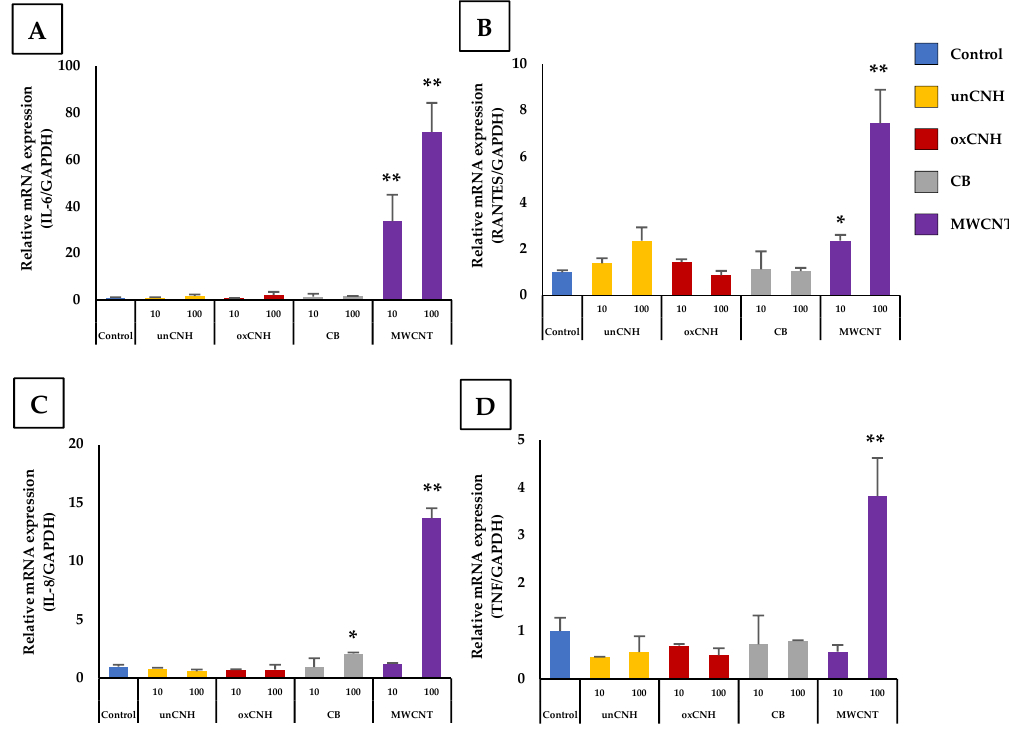
Figure 3. Gene expression of inflammation cytokines on HLEC exposed to varieties of carbon nanomaterials. ( A ) IL-6, ( B ) RANTES, ( C ) IL-8, ( D ) TNF. Data are expressed as mean ± S.E. ( n = 3). * p < 0.05; ** p < 0.01. HLEC, human lymphatic endothelial cell; unCNH, untreated carbon nanohorn; oxCNH, oxidized carbon nanohorn; CB, carbon black; MWCNT, multi-walled carbon nanotube.